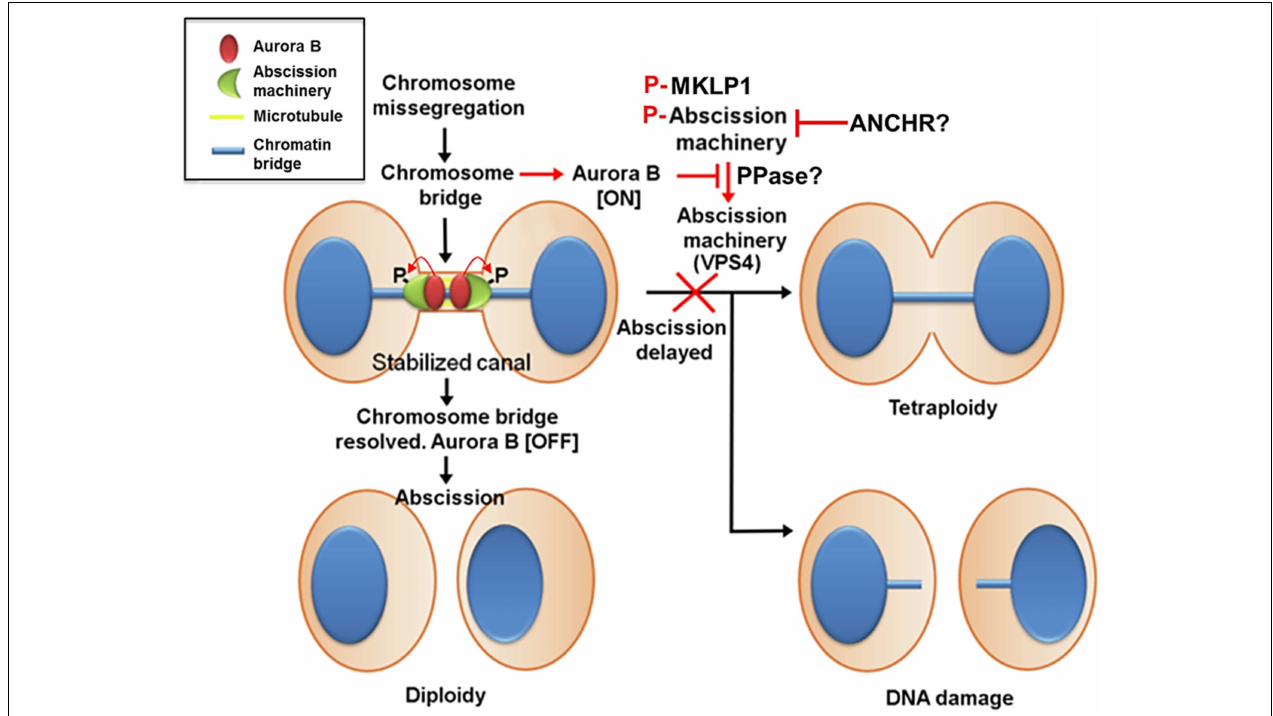
MKLP1 seems to stabilize the integrity of the midbody and intercellular bridge. Aurora B phosphorylation of CHMP4C on Ser210 imposes an abscission delay in response to a chromosome bridge that is trapped in the midbody. In concert with CHMP4C, ANCHR prevents VPS4 relocalization from the midbody ring to the abscission zone while it is relieved following the inactivation of Aurora B, thereby promoting membrane scission. However, it is unclear whether MKLP1, CHMP4C, and ANCHR-VPS4 act in the same pathway or whether they function independently downstream of Aurora B activity. Additionally, whether phosphatases antagonize Aurora B activity to promote abscission remains